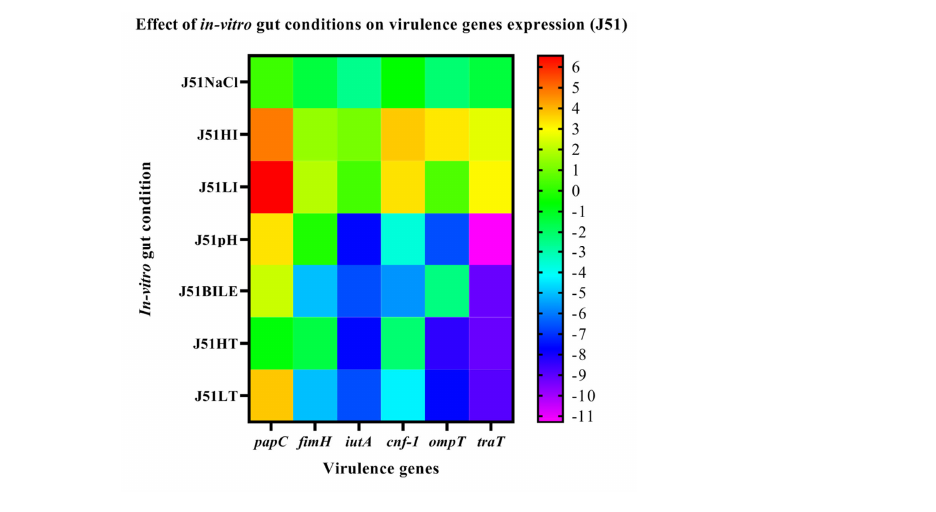
Figure 3. The expression level of virulence genes on exposure to in vitro gut conditions in J51 are presented using fold change values transformed to log2 format. The color scale indicating log2 (fold-change values) is shown towards the right of the heat map.